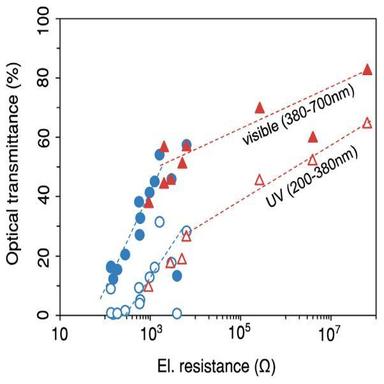
Correlation between electrical resistance, measured by 4-point probe method, and optical transmittance, in the UV (solid) and visible (empty) interval, for CNW (blue dots) and other carbon nanostructures (red triangles). (For interpretation of the references to color in this figure legend, the reader is referred to the web version of this article.)